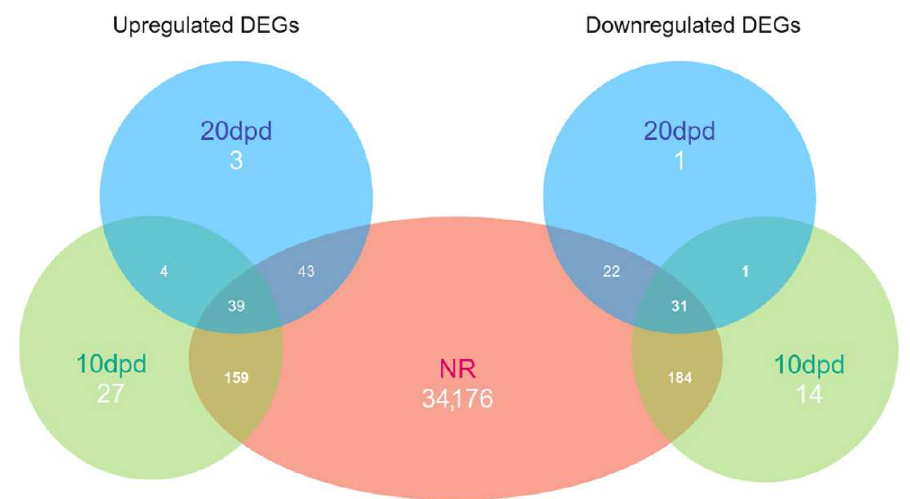
Figure 4. Venn diagram of up- and downregulated DEGs. NR—set of sequences with hits in the NCBI non-redundant database.